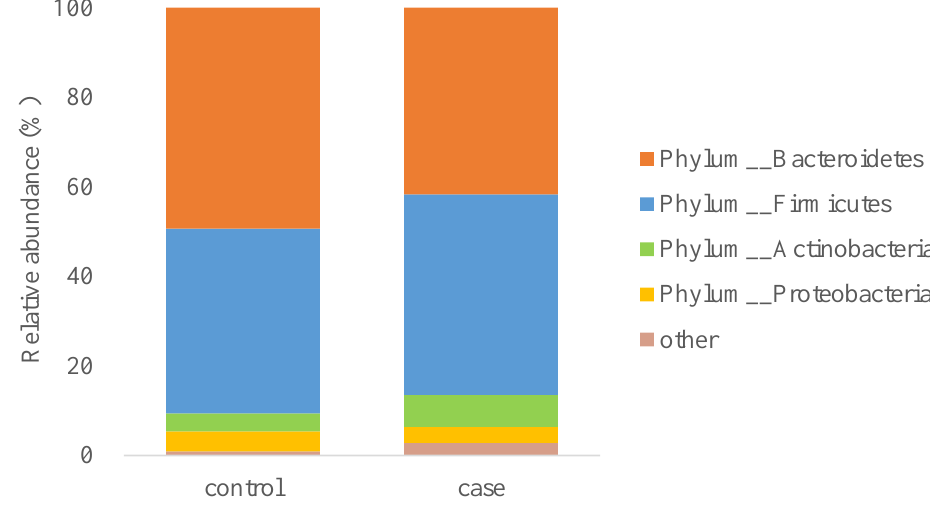
Figure 2. Relative abundance of various bacterial phyla.